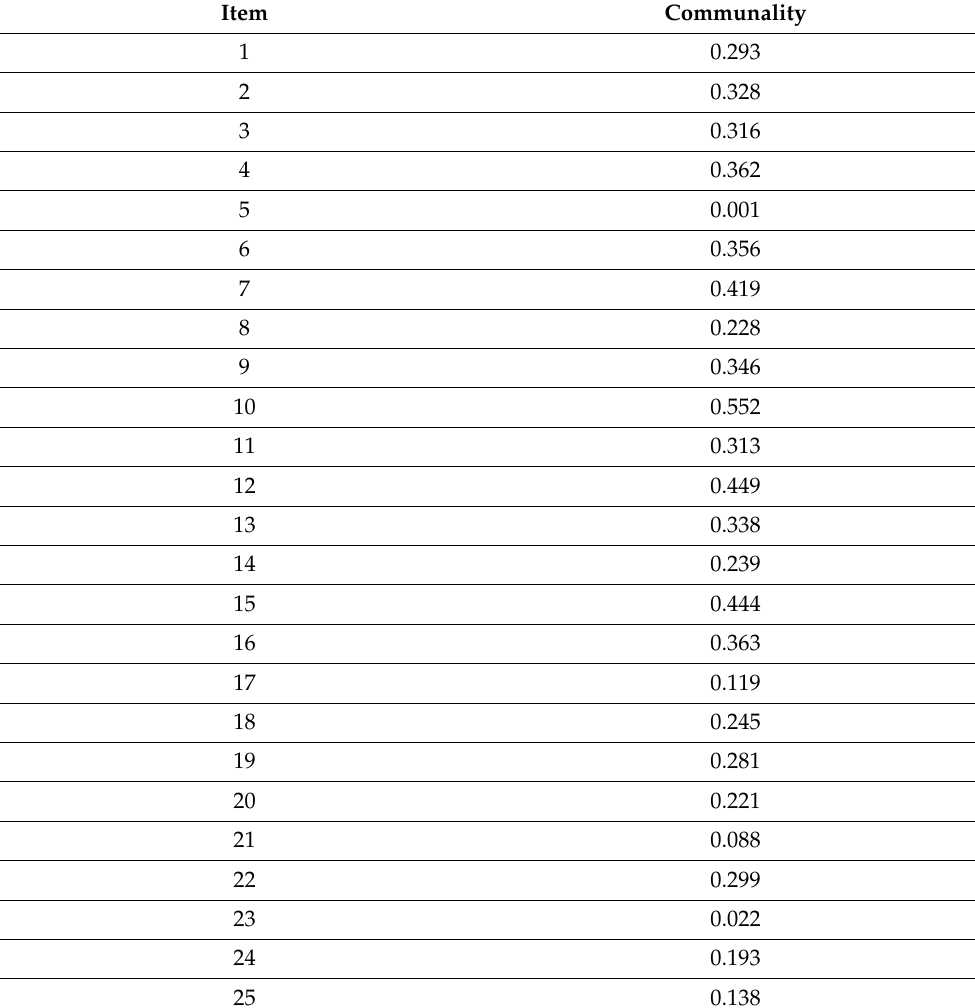
Table 2. Communalities between items of the Embodied Sense-of-Self Scale